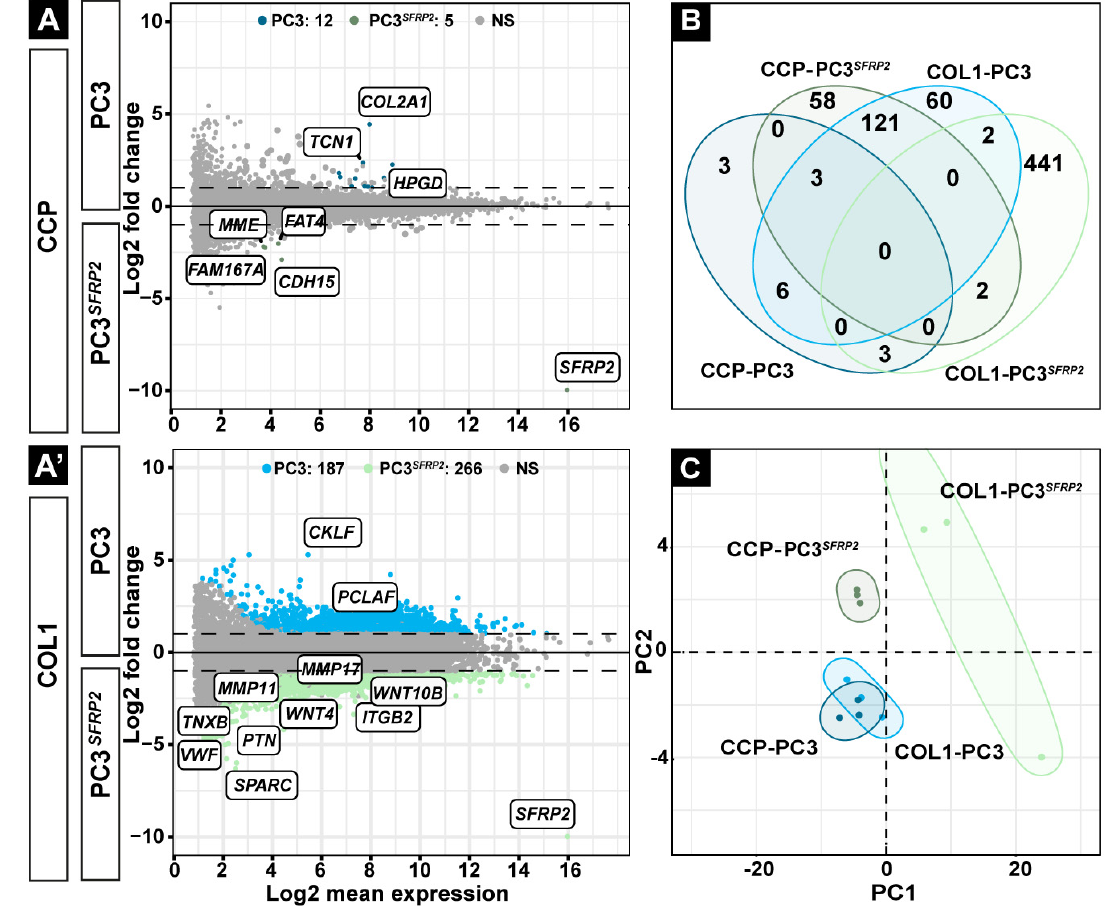
Figure 2. Differentially expressed gene (DEG) analysis of PC3 and PC3 SFRP2 cells. Next-generation RNA sequencing was performed to uncover genes that are affected by SFRP2 overexpression and surface condition. MA plots show gene expression differences between PC3 and PC3 SFRP2 on CCP ( A ) and COL1 ( A ′ ) surfaces. Genes that may influence osteomimicry were labelled in MA-plots. NS: not significant, blue: significantly upregulated in PC3, green: significantly upregulated in PC3 SFRP2 . The Venn diagram illustrates the number of unique upregulated genes specific to each group ( B ). Principal component analysis (PCA) revealed a strong transcriptional response of PC3 SFRP2 cells on COL1, when compared to PC3 SFRP2 on CCP surface ( C